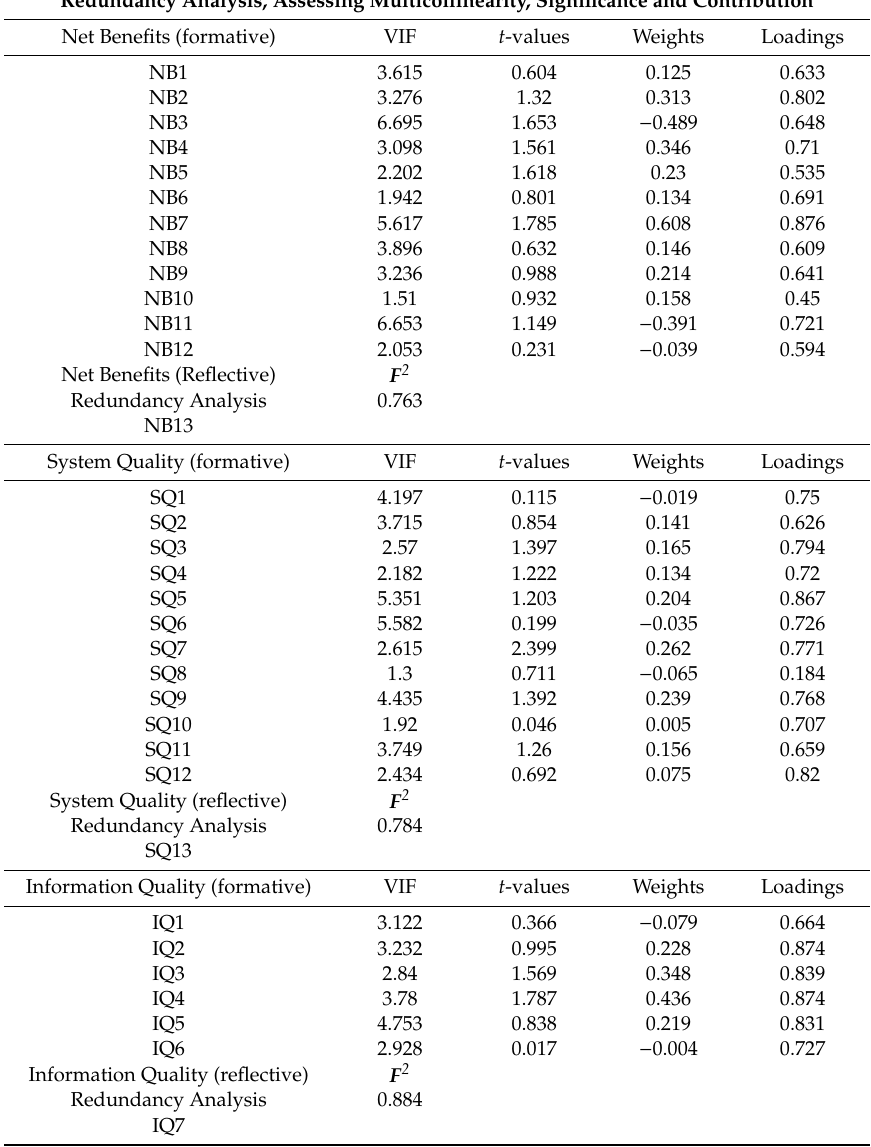
Table 8. Quantitative Assessment of Measurement Model